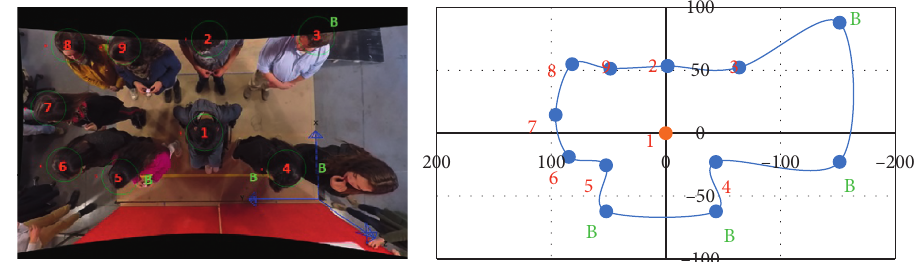
Figure 7: Sequence of detections using the PeTrack